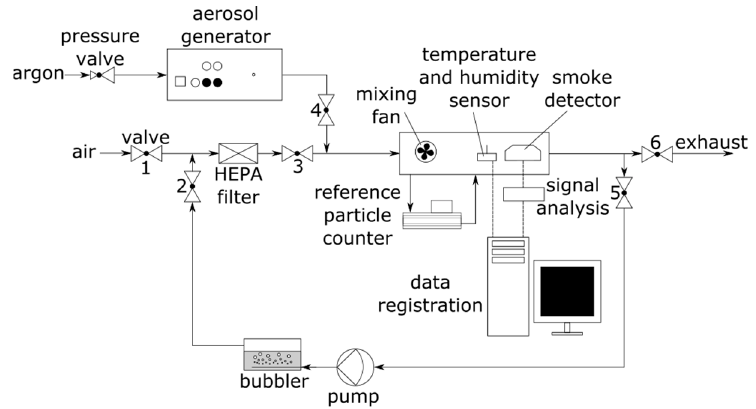
Figure 3. Experimental setup.